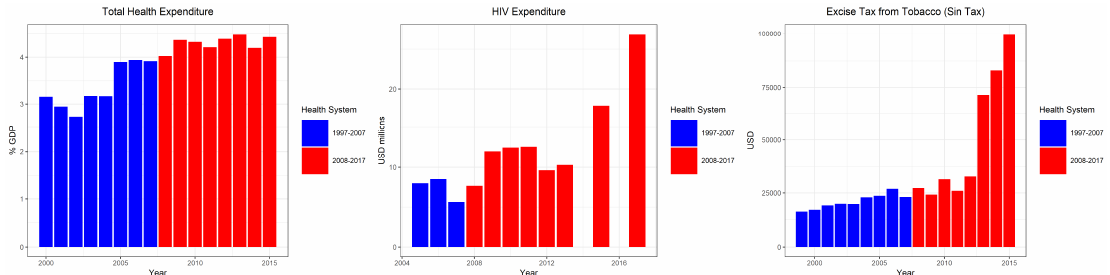
Figure 6. Health financing parameters (total health expenditure, HIV expenditure, tobacco excise tax) in either of the health system